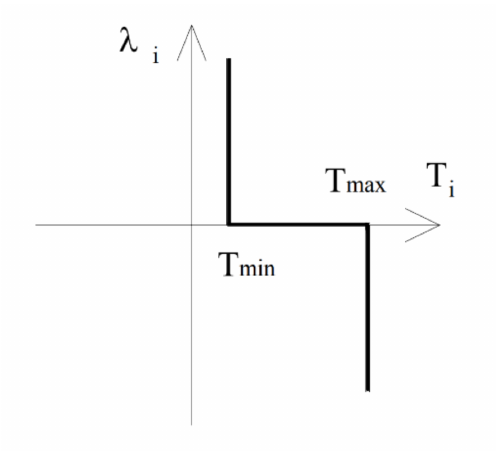
Figure 9. Schematic plot illustrating relationship (50) where T ∈ [ T min , T max ] , λ i —i-th parame- ter of the optimization vector, T i —i-th friction force, T min —minimum value of the friction force, T max —maximum value of the friction